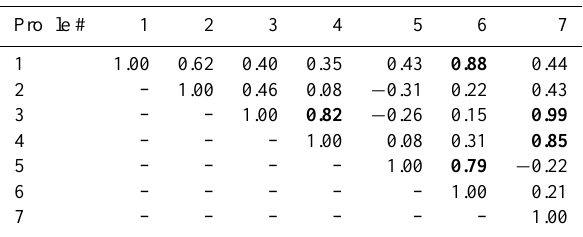
Table 4. Linear correlation coefficients for a monthly series (30000 samples, January 2007) of ζ deviation values for seven test cloud